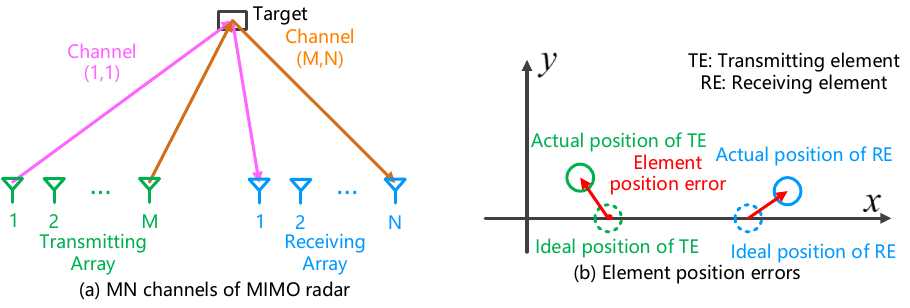
Figure 1. Array errors of MIMO imaging radar. As shown in Figure 2, the geometric center of the transmitting array is used as the coordinate origin, the line along the transmitting array is used as the y axis, and the target P is located in the positive direction of the x axis. Because of the element position errors, the TEs are not completely collinear. It is assumed that the coordinates of all the TEs and REs are ( (cid:101) x T , m , (cid:101) y T , m ) , m = 1, 2, . . . , M and ( (cid:101) x R , n , (cid:101) y R , n ) , n = 1, 2, . . . , N , respectively.